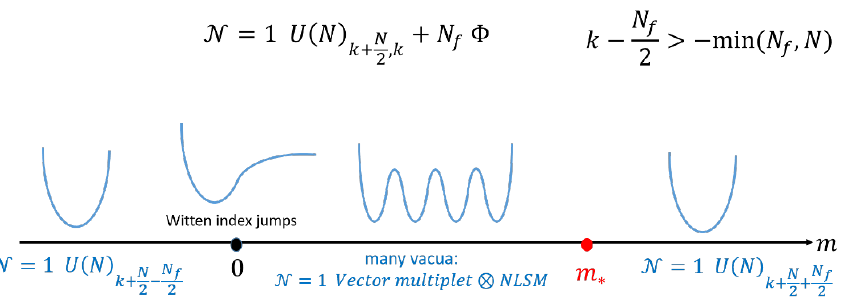
gauge theory coupled to a N f k + 2 ( N + N f ) ;k + 1 N f 1 2